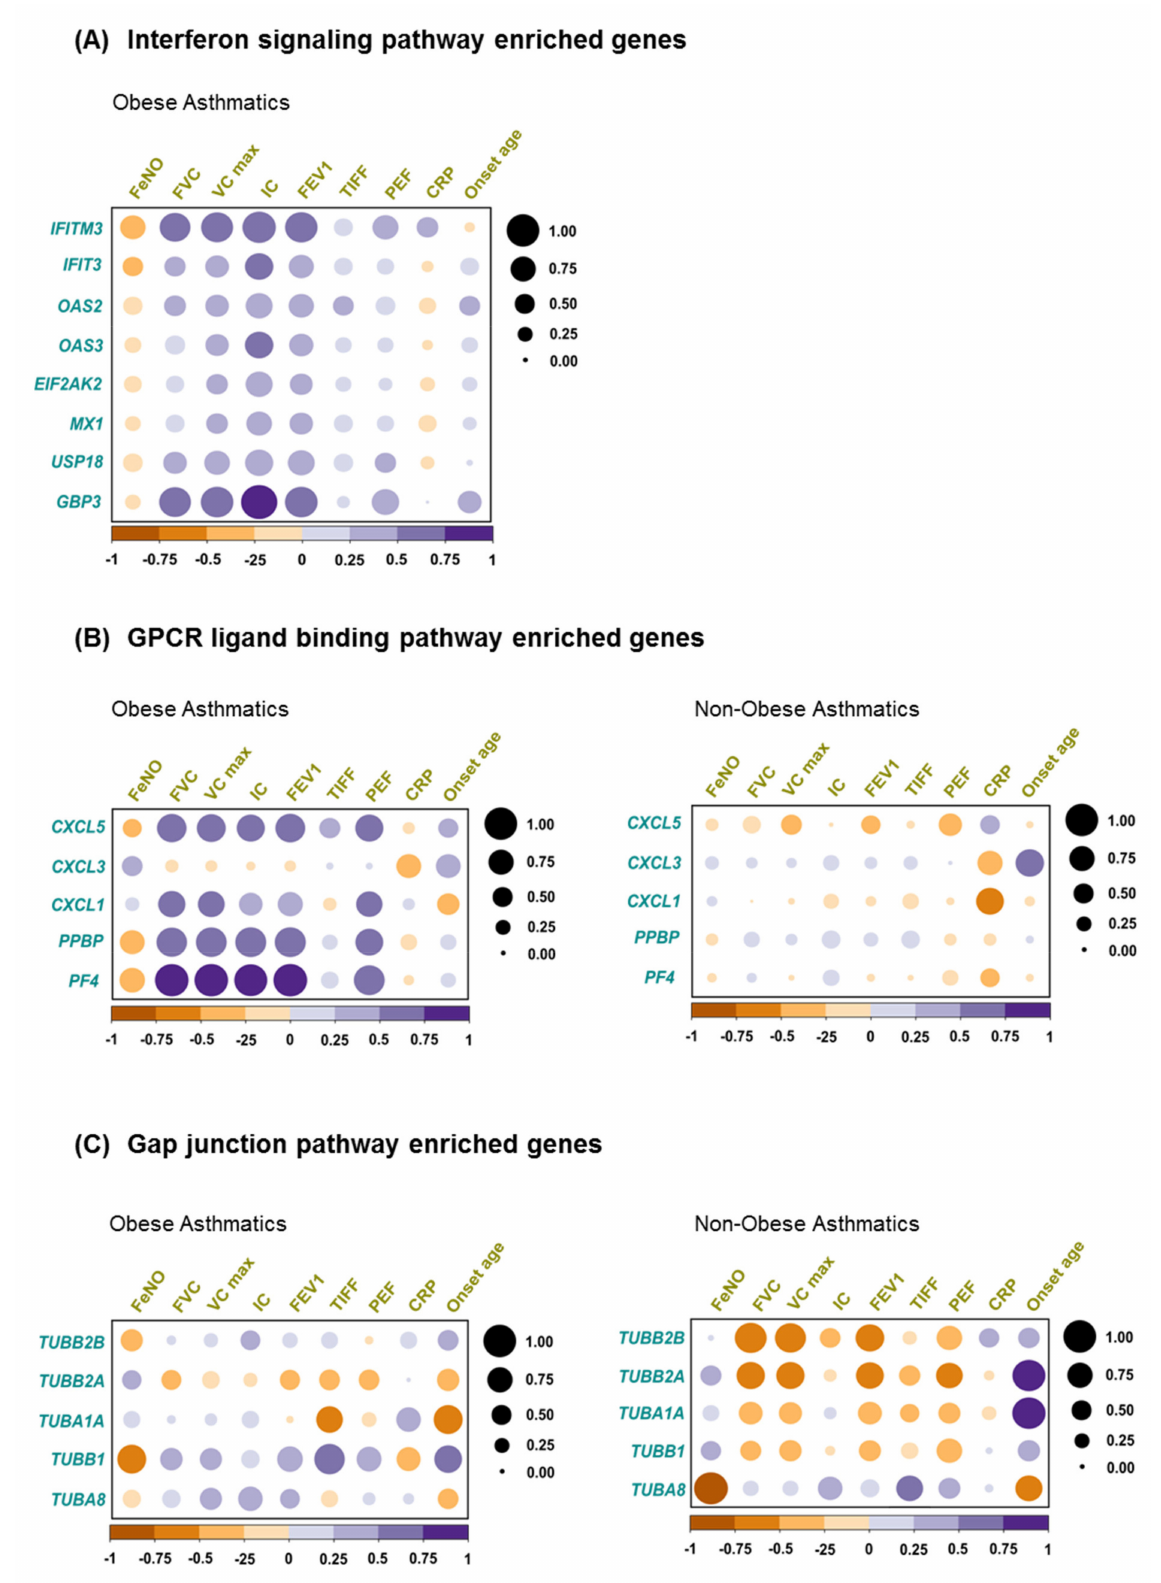
Figure 4. Correlation between clinical variables and biological pathways enriched genes. Pearson correlation between clinical assessments and ( A ) interferon signaling pathway enriched genes in obese asthma, ( B ) gap junction pathway enriched genes in both obese asthmatics and non-obese asthmatics, and ( C ) GPCR ligand binding enriched genes in both obese asthmatics and non-obese